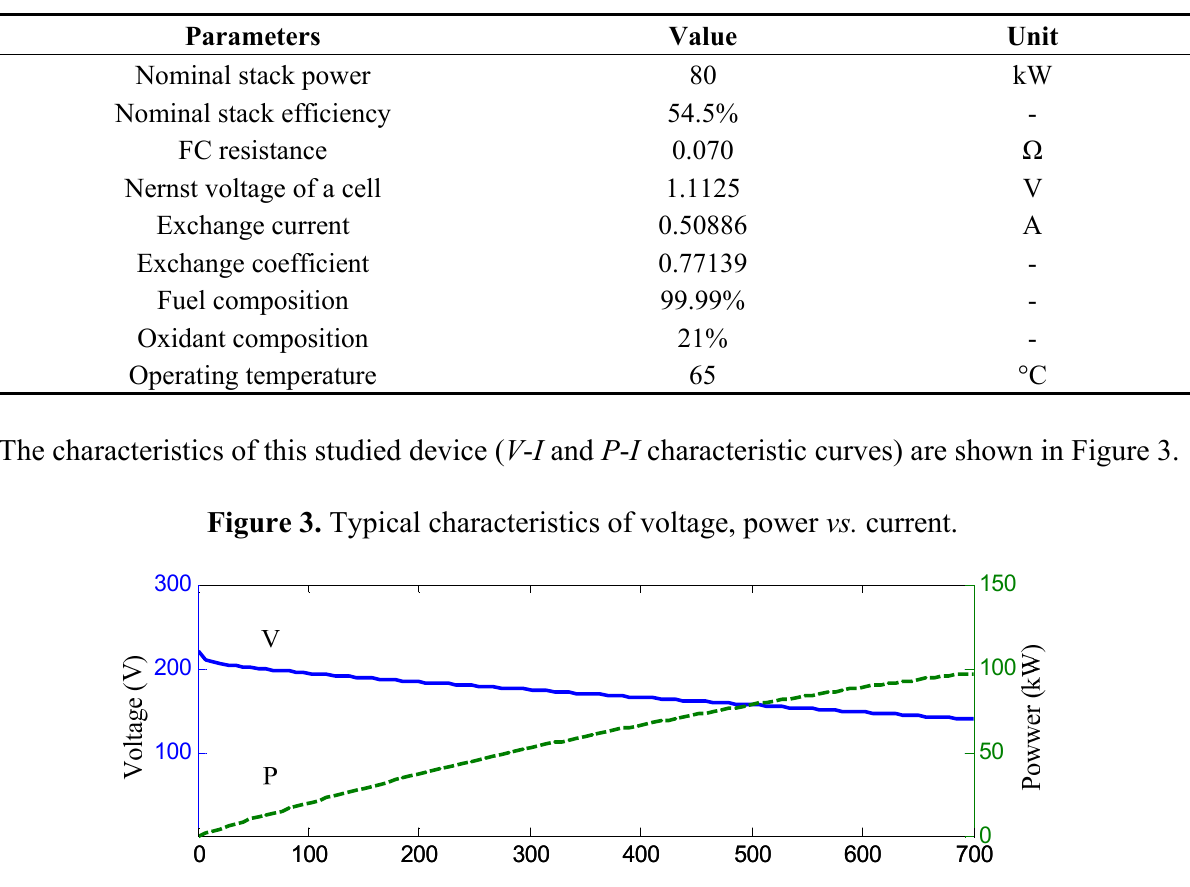
Table 2. Parameters of PEMFC.